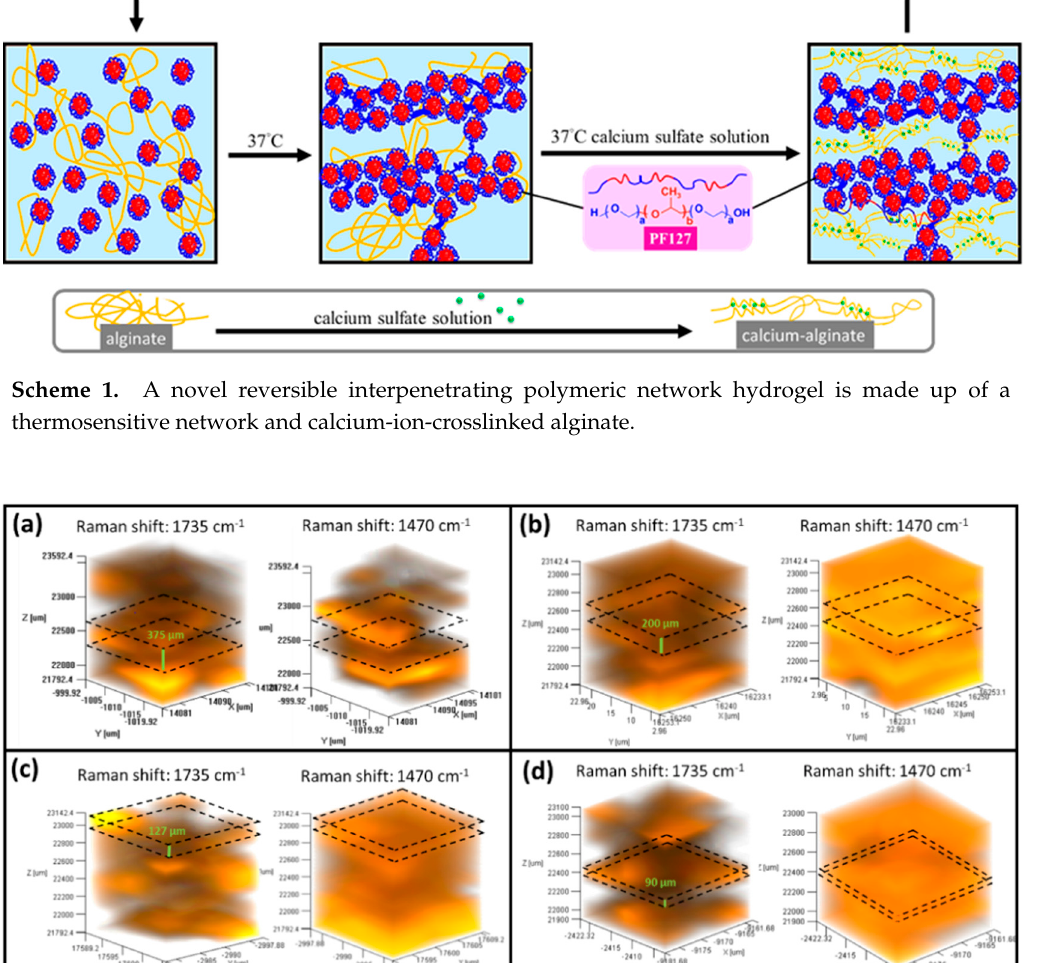
Scheme 1 . A novel reversible interpenetrating polymeric network hydrogel is made up of a thermosensitive network and calcium-ion-crosslinked alginate.